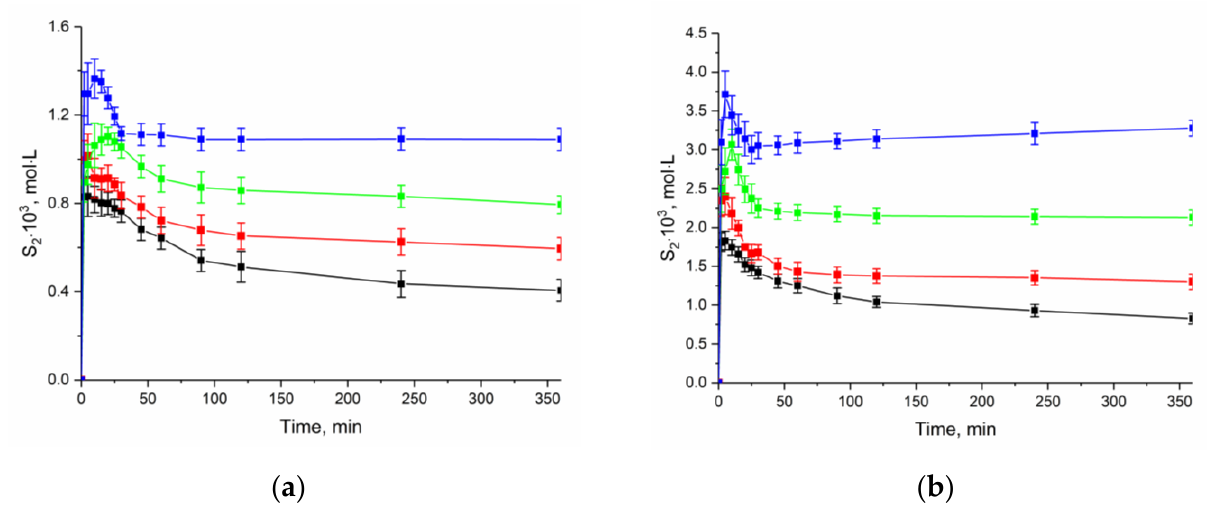
Figure 7. Effect of temperature on the dissolution profiles of the anhydrate NFT in buffer solutions ( a ) pH 2.0 and ( b ) pH 7.4. ( – ■ – 298.15 K; – ■ – 303.15 K; – ■ – 308.15 K; – ■ – 313.15 K).